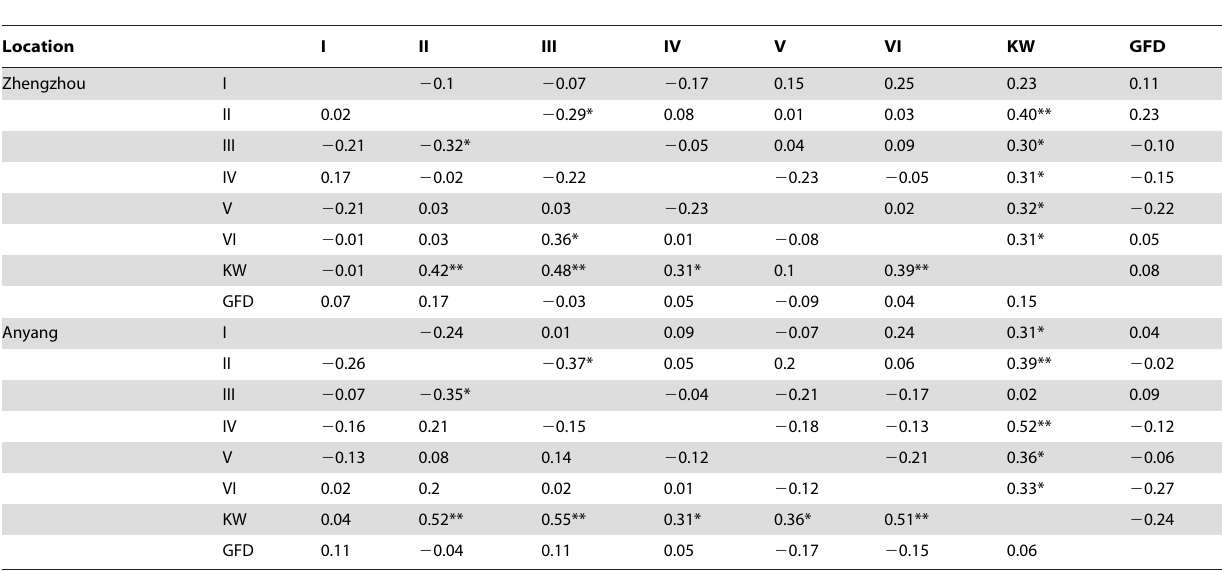
Table 2. Correlation coefficients between grain filling rate, grain filling duration and final kernel weight.